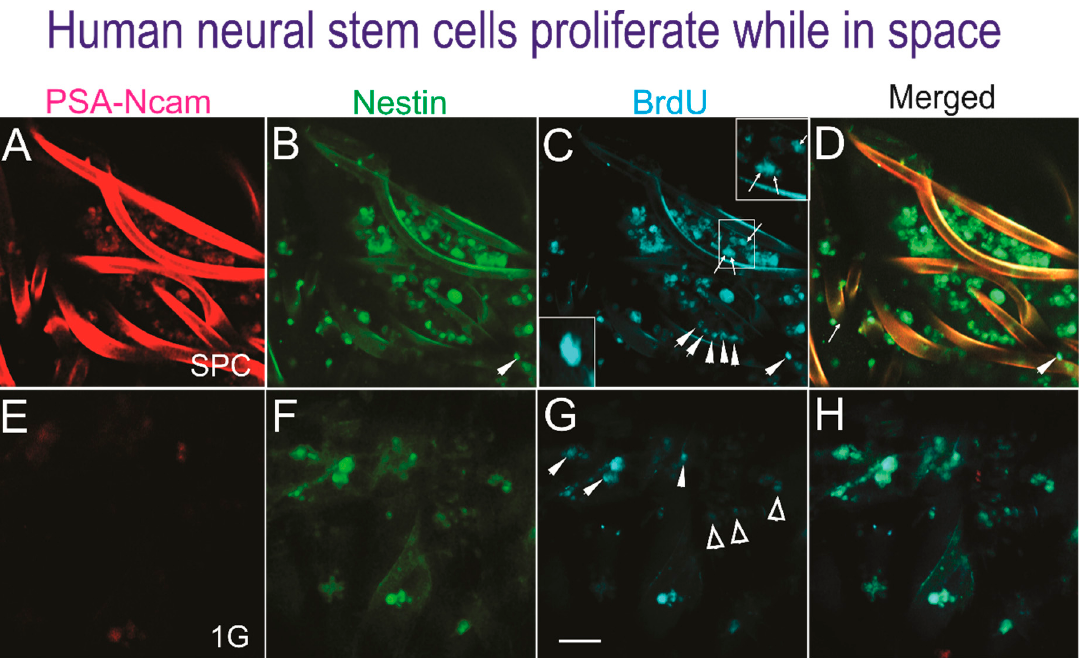
Figure 2. Human NSCs proliferate in space . Triple immunofluorescence performed on cells adhered to the mesh-cell carrier. A to D show NSCs that proliferated while in space. E to H show views of ground control NSCs. ( A ) The PSA-NCAM antibody labeled most but not all cells. ( B ) Cells expressing nestin as seen by the intensity of the marker in all NSCs. ( C) Different intensities of BrdU-labeled cells, some organized in rows (arrowheads) or as dividing cells (arrows) as shown in the insets. ( D ) Most cells expressed BrdU and nestin and a subpopulation colocalized with PSA-NCAM. ( E ) PSA-NCAM was not expressed by the NSCs grown in 1 G (ground control). ( F ) Some cells expressed nestin at different intensities and others were negative. ( G ) Only some cells intensely expressed BrdU (arrowheads), while most had a faint expression (open arrowheads) or were negative. ( H ) The merged image shows that there were less cells in 1 G (ground controls) with respect to the cells sent to space. The BrdU incubation was for 72 h for all cells in automated units. (Bar = 50 µm).